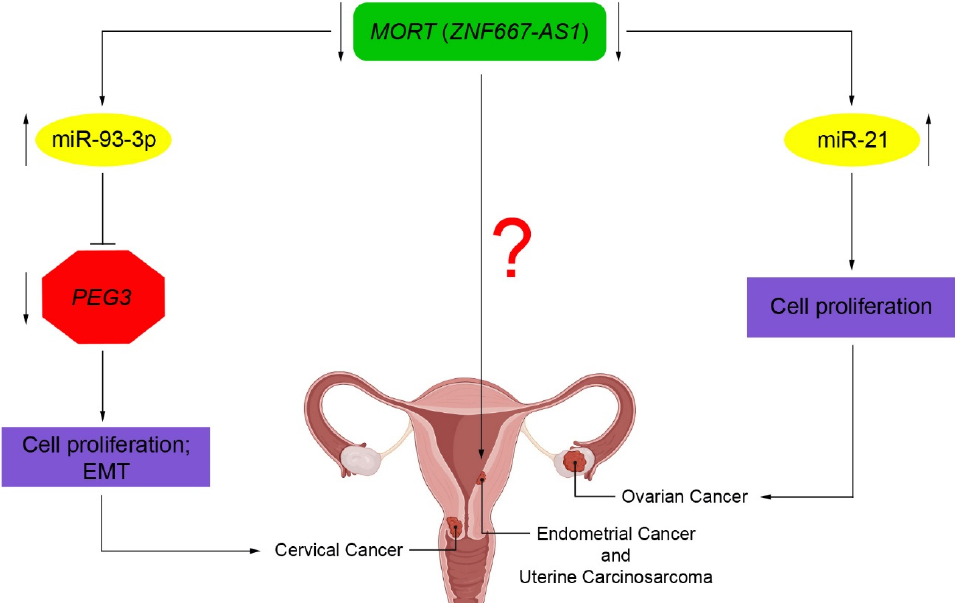
Figure 2. Pathological role of MORT ( ZNF667-AS1 ) in gynecological cancers. Underexpression of MORT ( ZNF667-AS1 ) could promote tumor initiation in ovarian, cervical, and endometrial cancers through different molecular mechanisms not yet well explored. In ovarian cancer, MORT ( ZNF667-AS1 ) downregulation and consequent miR-21 overexpression promote the proliferation of ovarian cancer cells. In cervical cancer, downregulation of MORT ( ZNF667-AS1 ) and consequent overexpression of miR-93-3p reduce the expression of PEG3 , thereby allowing cell proliferation and EMT. In endometrial cancer and uterine carcinosarcoma, MORT ( ZNF667-AS1 ) expression is silenced by aberrant DNA methylation. However, its function mechanism in these types of cancer is unknown. BioRender has been used to create parts of this figure. (https://biorender.com, accessed on 18 May 2021).